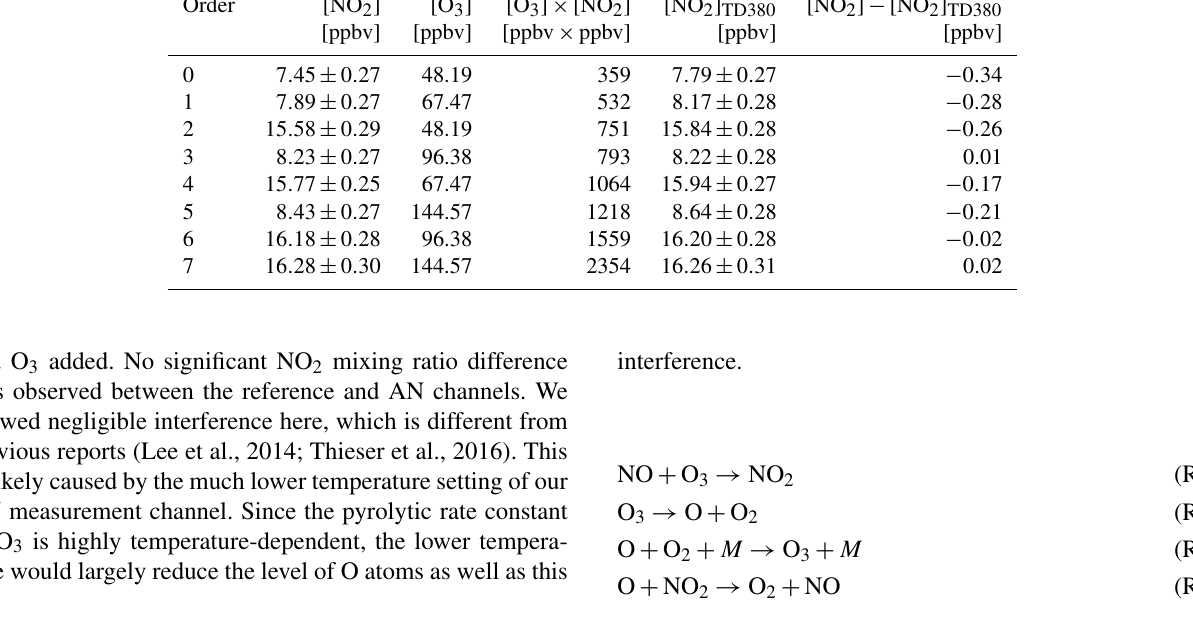
Figure 8. Model-simulated thermal decomposition profiles of PAN and MeN with different amounts of PAN or MeN under different wall loss rate coefficients of RO 2 . Panels (a) and (b) show the NO 2 signals of PAN and MeN when the wall loss rate coefficient of RO 2 is 0.3s − 1 . Panels (c) and (d) show the NO 2 signals of PAN and MeN when the wall loss rate coefficient of RO 2 is 5s − 1 . Table 1. Measurements of the NO 2 mixing ratio in three channels of the TD-CEAS with different added amounts of NO 2 and O 3 .